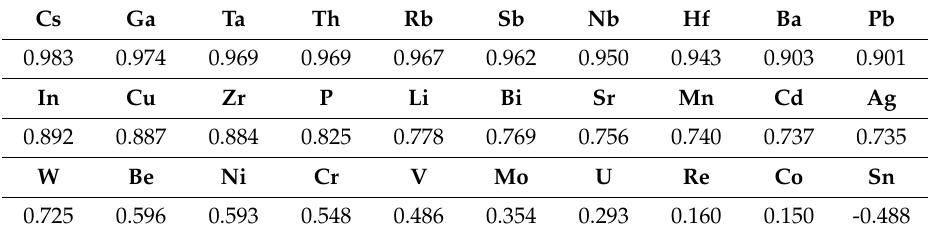
Table 4. Correlation coefficients between the ash yield and various trace elements.